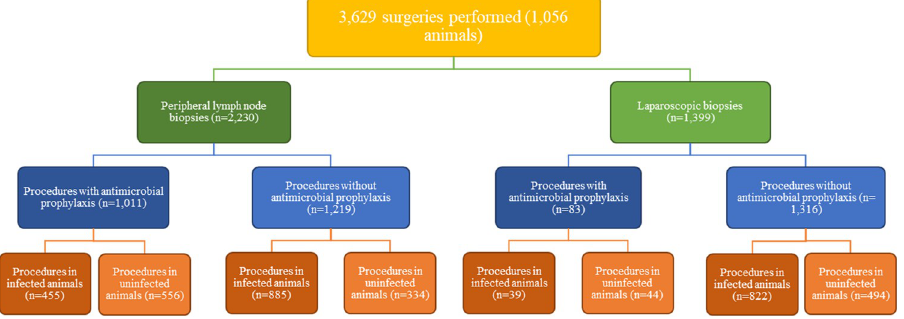
Fig 1. Flow chart for retrospective study group